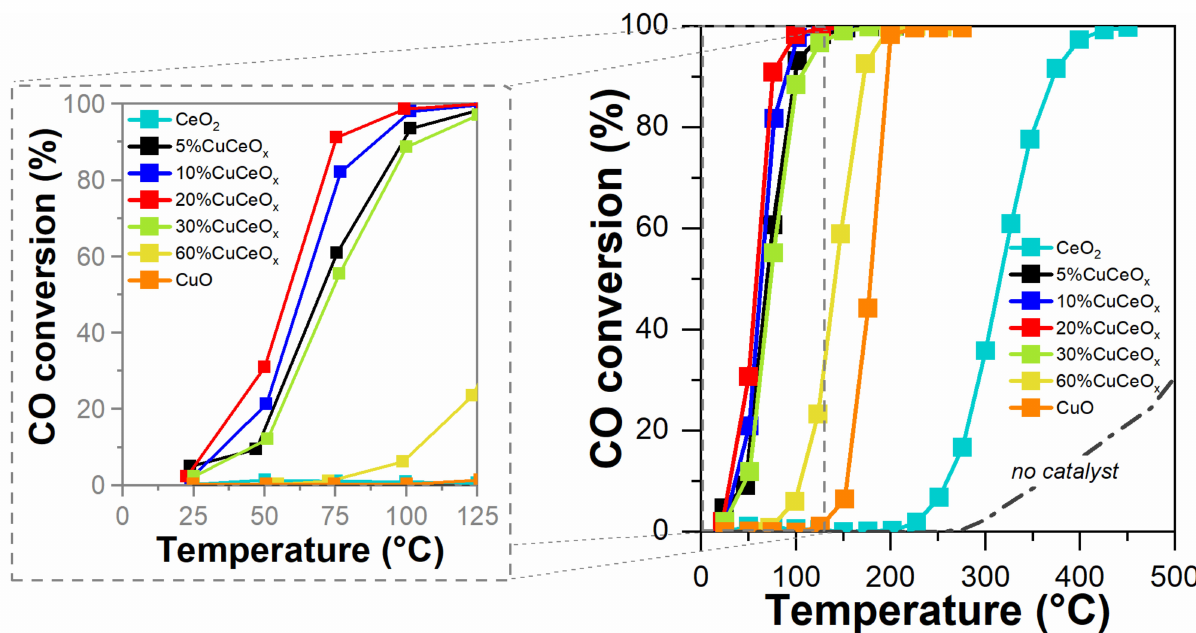
Figure 7. CO conversion as a function of the temperature in the range 0–500 ◦ C (black graph) and a magnification in the range 0–125 ◦ C (grey graph). Table 6. Catalytic performances of the prepared samples in the catalytic oxidation of CO.